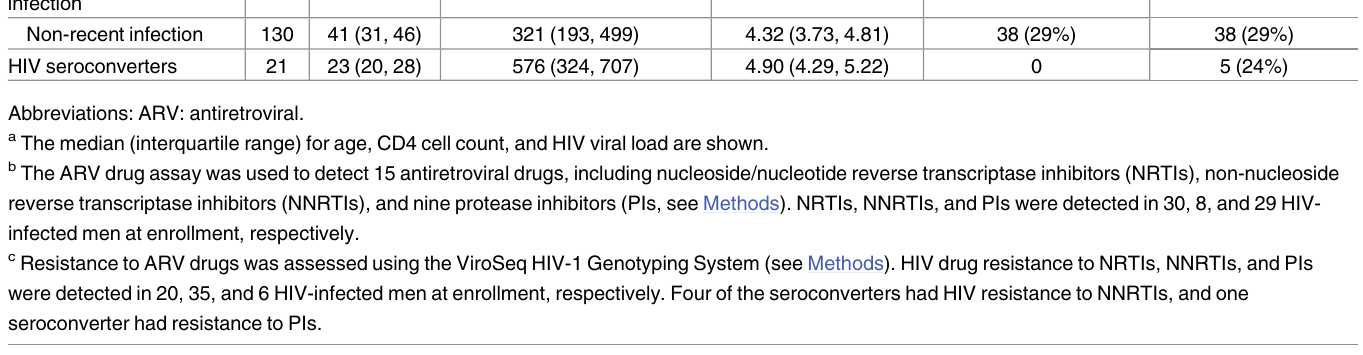
Table 1. Summaryof study participants. Subset